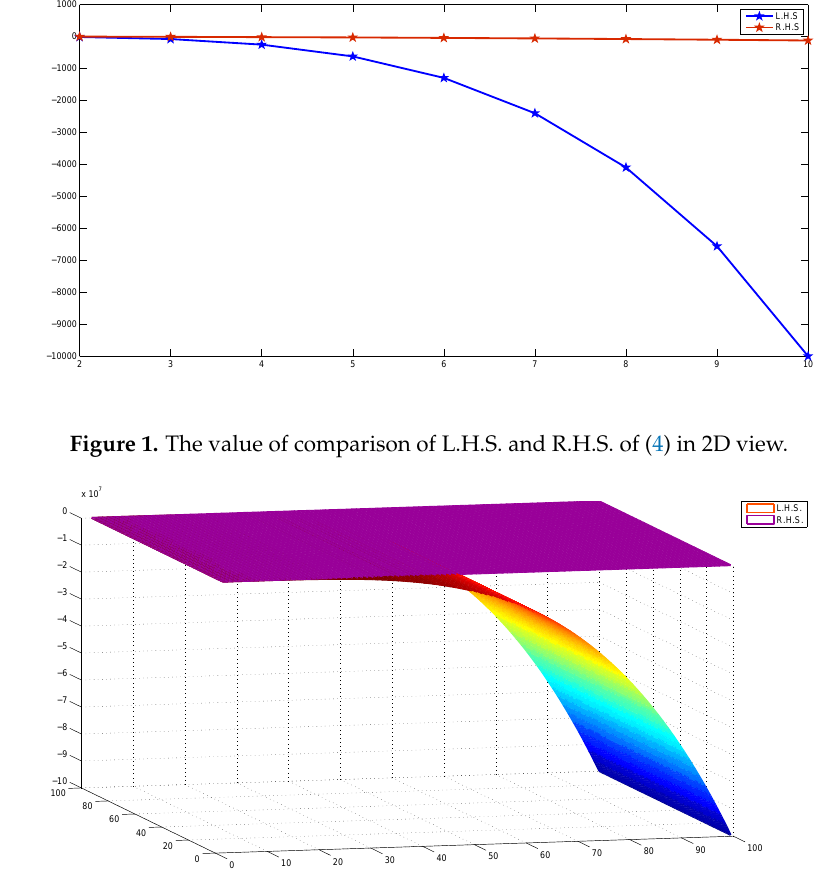
Figure 2. The value of comparison of L.H.S. and R.H.S. of (4) in 3D